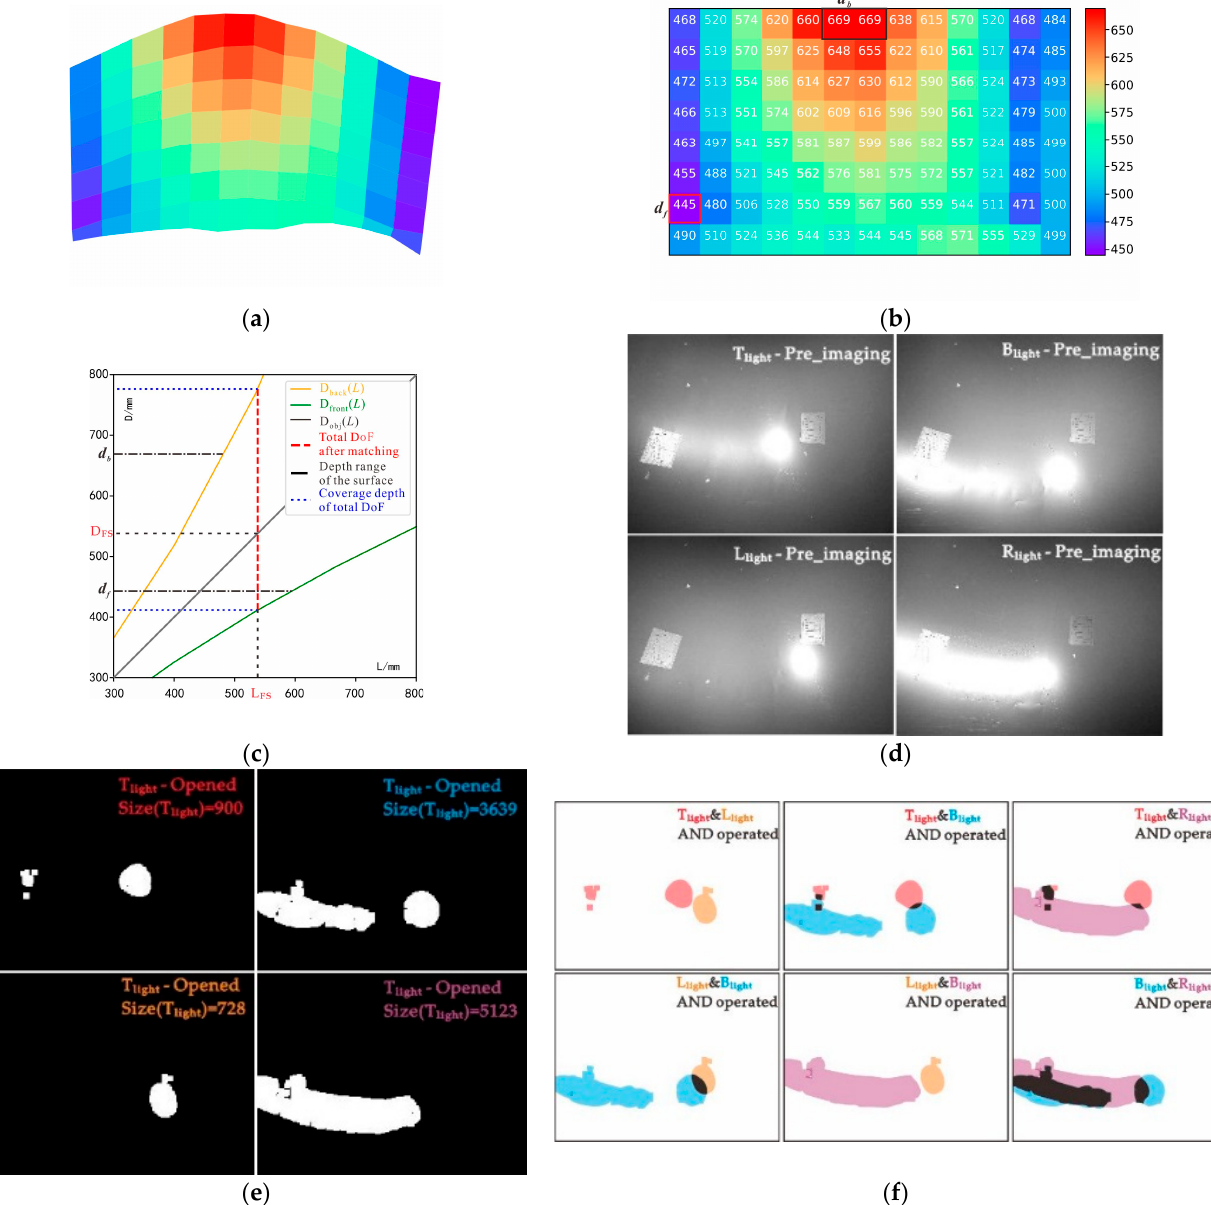
Figure 9. Decision-making process under viewpoint ii: ( a ) surface simulation; ( b ) data of depth distribution; ( c ) all-in-focus imaging scheme; ( d ) images of pre-imaging; ( e ) pre-imaging images after “open operation”, where the four different colors in this figure represent the different light sources. For example, the image with a red color character represents the image obtained under T light , and the blue, orange, and purple colors represent B light , L light , and R light respectively. ( f ) Inferred images after “operation” between two different pre-imaging images, where the meaning of the color is similar to that shown in Figure 9e, and the area with black color represents the inferred area where the spots of different light sources coincide. Table 3. Decision parameters of the dynamic lighting scheme.